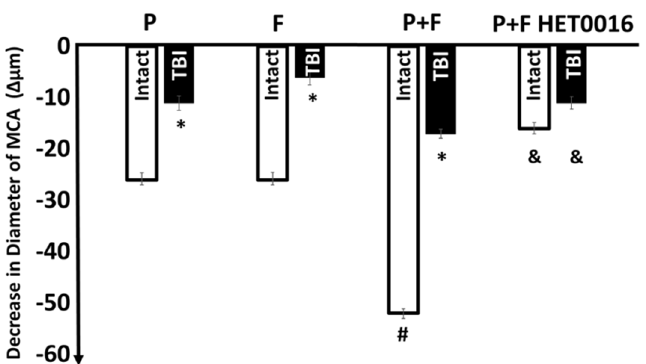
Figure 2. Shows the pressure (P)- or flow (F)-induced decreases in diameter alone, or the additive effect of pressure + flow on the diameter of MCA from intact rats. Additionally, Figure 2 shows that traumatic brain injury (TBI) significantly reduced the pressure (P)-, flow (F)-, and thus combined pressure + flow (P+F)-induced constrictions of MCAs (* indicates significant changes from Intact, # from P alone and F alone, and & from P+F ( n = 24, data are mean ± SEM, p < 0.05) Moreover, this figure shows that HET0016 (10 − 6 mol/L), an inhibitor of cytochrome P450 4A (CYP450 4A), inhibited substantially and significantly the constriction induced by pressure + flow ( n = 6 in each group).